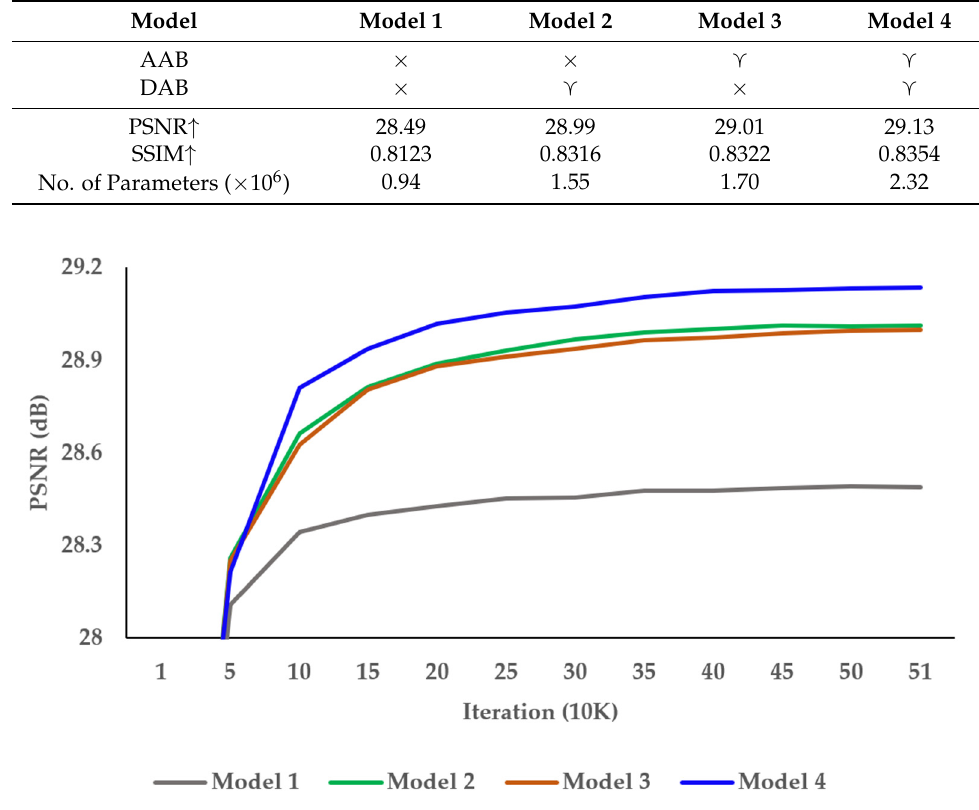
Figure 10. Investigations of the alignment block.